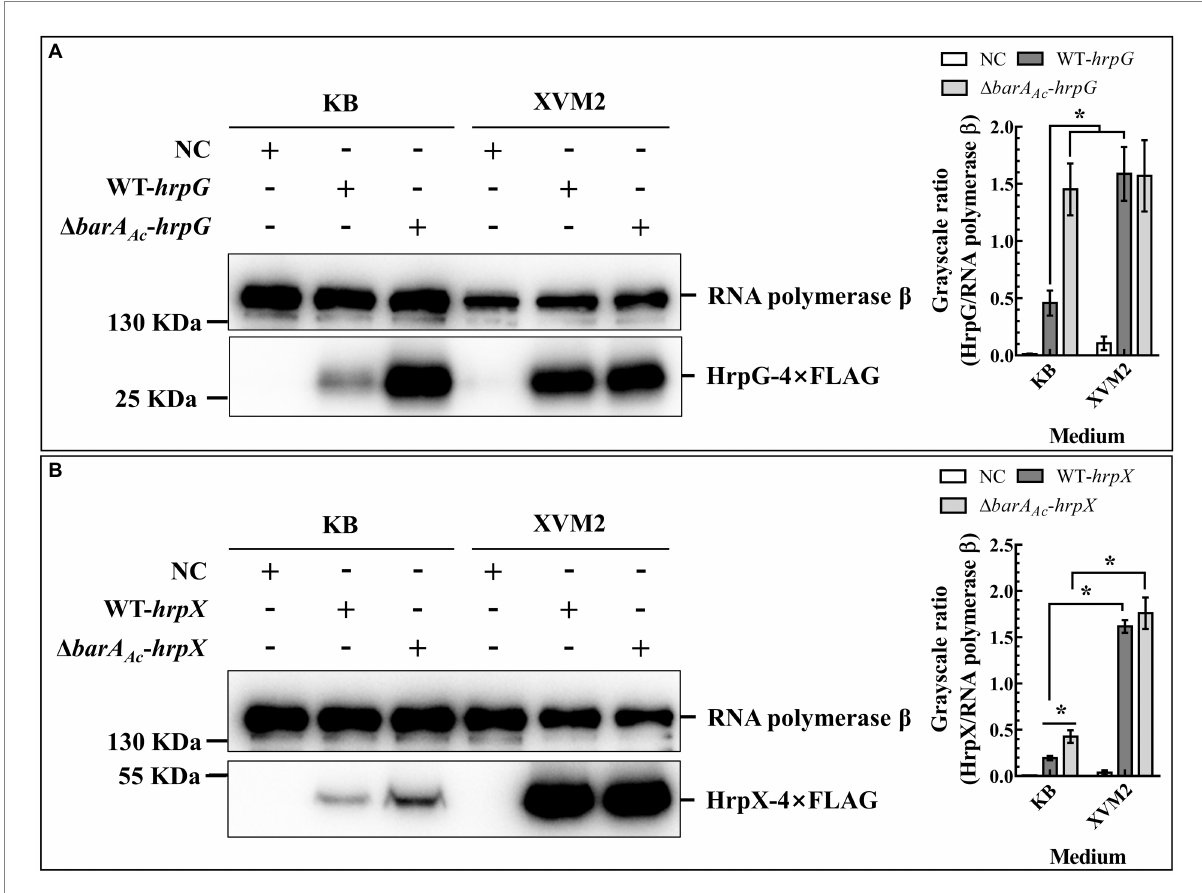
FIGURE 5 The deletion of barA Ac enhanced the expression of HrpG and HrpX in Acidovorax citrulli . The expression of HrpG (A) and HrpX (B) detected by Western blot in the wild-type strain WT- hrpG and the barA Ac deletion mutant strain Δ barA Ac - hrpG carrying pBBR- hrpG -4Flag, and the wild-type strain WT- hrpX and the barA Ac deletion mutant strain Δ barA Ac - hrpX carrying pBBR- hrpX -4Flag in King’s B medium and XVM2 medium. The negative control (NC) was the wild-type strain Aac5 carrying pBBRNolac-4Flag. RNA polymerase β was used as a control for protein loading. The bar chart shows the quantitative protein expression levels (the mean value of the grayscale ratios) calculated using Image J (National Institutes of Health, United States). The error bar represents the standard deviation, and *indicates significant difference between treatments ( t -test, p <